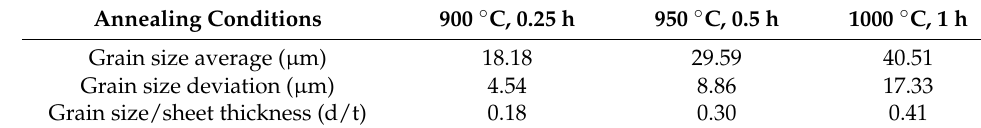
Figure 1. Microstructures of the 316LN stainless steel annealed at ( a ) 900 °C, ( b ) 950 °C and ( c ) 1000 °C. Table 1. Heat-treatment parameters and the corresponding grain sizes.